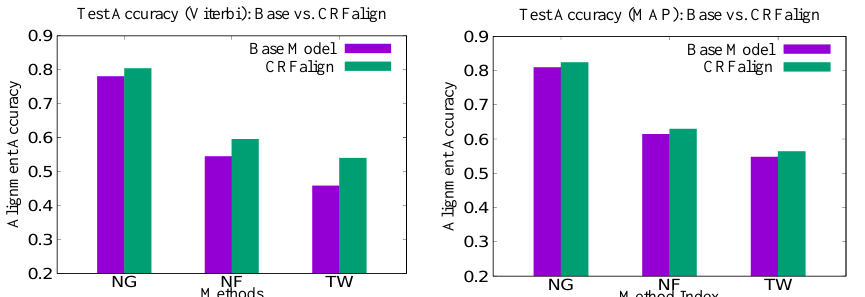
Figure 4. Training and test accuracies at Maximum for ( left ) the Viterbi alignment as well as ( right ) the MAP alignment on the three sets (NG, NF and TW) of 200 reference alignments with the three-state